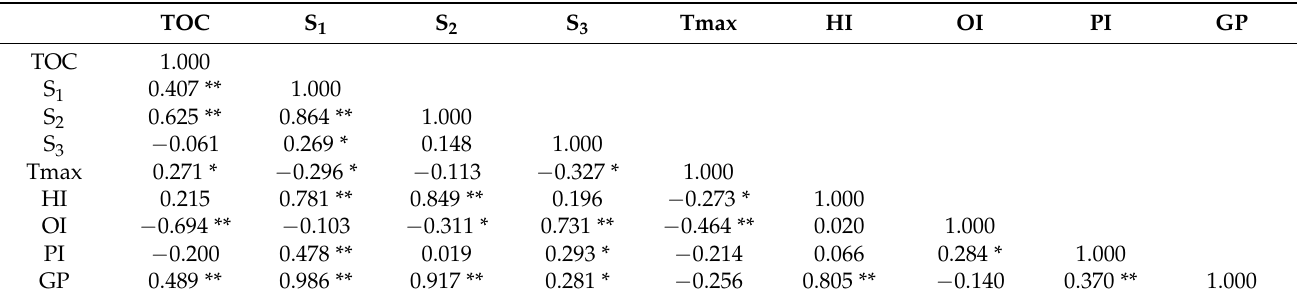
Table 2. Spearman’s correlation coefficient ( ρ ) between pyrolysis parameters for the studied Montney Formation